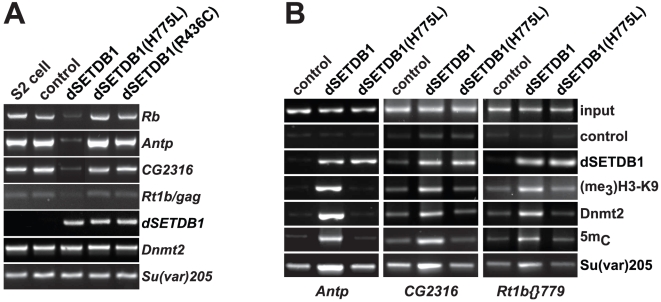
DSETDB1-mediated tri-methylation of H3-K9 initiates DNA methylation and silencing.(A) Digital images of ethidium bromide-stained agarose gels showing the reaction products of RT-PCR assays monitoring the transcription of Rb, Antp, CG2316, Rt1b/gag, dSETDB1, Dnmt2, Su(var)205 and actin5C in total RNA pools isolated from S2 cells, S2 cells transiently expressing GFP (control), and S2 cells co-expressing GFP and dSETDB1, dSETDB1(H775L), or dSETDB1(R436C). (B) Digital images of ethidium bromide-stained agarose gels showing the products of PCR assays detecting the dSETDB1 target DNA sequence in Antp, CG2316, and Rt1b{}799 (see Figure S9) in DNA pools obtained by ChIP. Chromatin was isolated from cells described in (A) and immunoprecipitated with antibodies and controls as described in Figure 2C. 1% of the chromatin used for ChIP.